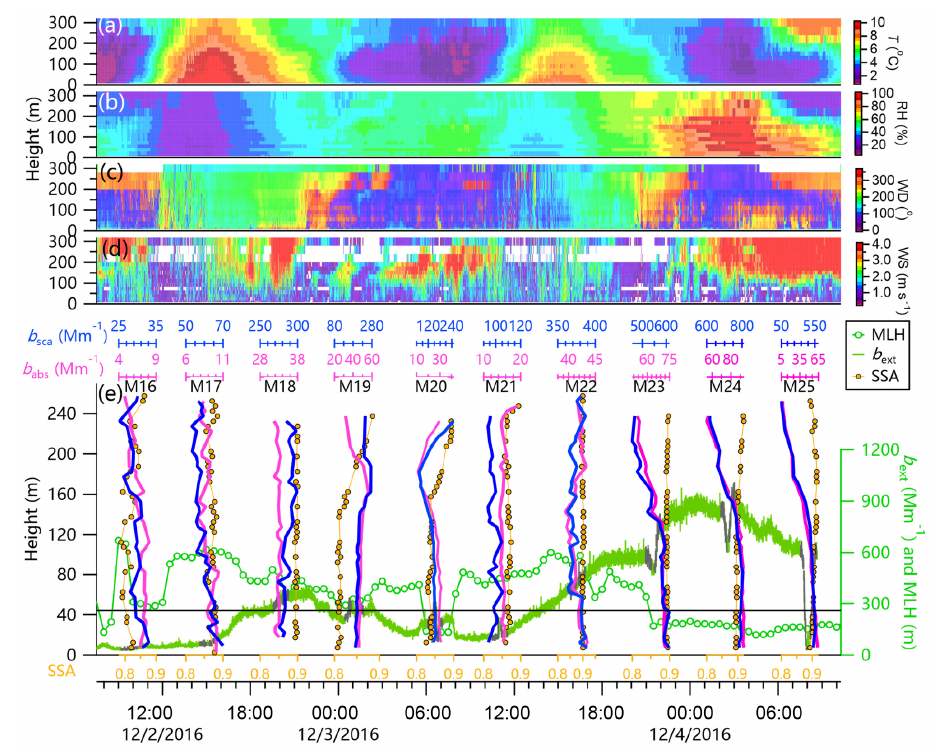
Figure 7. Evolution of vertical profiles of b sca , b abs , and SSA during 2–4 December. Also shown are (a–d) meteorological variables of T , RH, WD, and WS, as well as (e) time series of b ext at ground and MLH. M16–M25 refer to the number of vertical profiles.